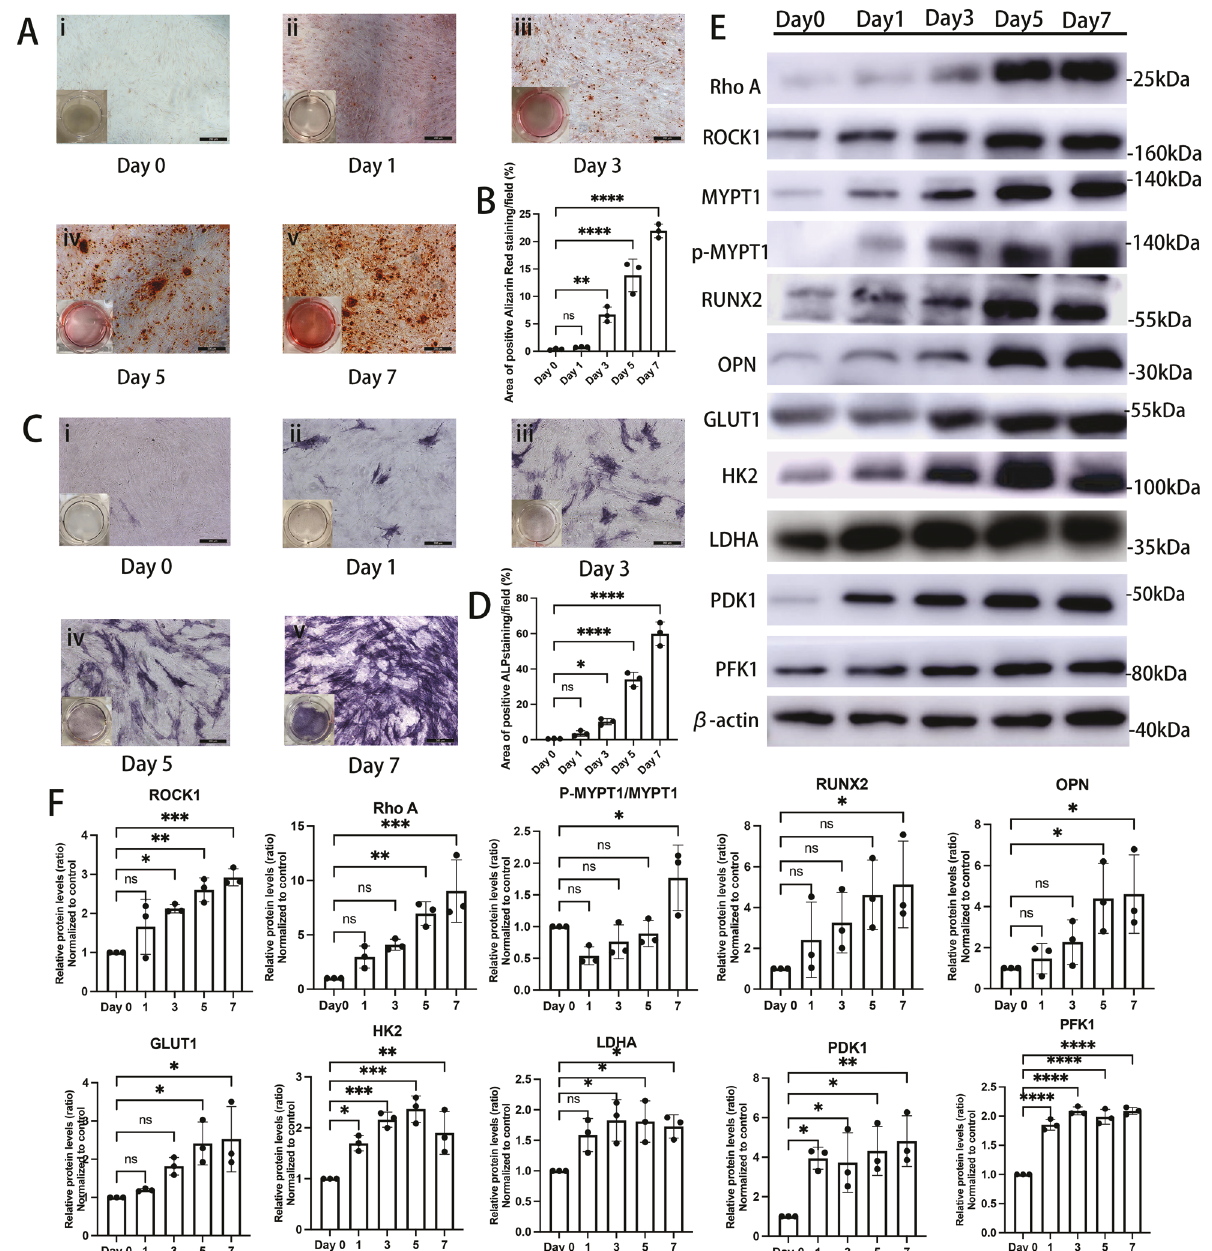
Fig. 2 IP-induced osteogenic differentiation of human VICs in vitro. A Alizarin red staining of human VICs under osteogenic stimulus for 0 (i), 1 (ii), 3 (iii), 5 (iv) and 7 (v) days. Scale bar = 200 µm. B Quanti fi cations of data presented in A (one-way ANOVA followed by Bonferroni post hoc test). C Alkaline phosphatase staining of human VICs under osteogenic stimulus for 0 (i), 1 (ii), 3 (iii), 5 (iv) and 7 (v) days. Scale bar = 200 µm. D Quanti fi cations of data presented in C (one-way ANOVA followed by Bonferroni post hoc test). E Western blotting and ( F ) quantitation for Rho A, ROCK1, MYPT1, p-MYPT1, OPN, RUNX2, GLUT1, LDHA, HK2, PFK1 and PDK1 of human VICs under osteogenic stimulus for 0, 1, 3, 5 and 7 days (one-way ANOVA followed by Bonferroni post hoc test). β -actin was used as loading control. Data are shown as mean ± SD. * P < 0.05, ** P < 0.01, *** P < 0.001, **** P < 0.0001. (Fig. 4H). Consistently, downregulation of AMPK activity dramati- cally decreased Y27632-induced upregulation of RUNX2 ubiquiti- nation in calci fi ed human VICs (Fig. 4I). Also, the half-life of RUNX2 of Y27632-treated calcifying VICs under conditions of Compound C were much higher than those only cultured with Y27632 (Fig. 4J and K). While no impact of AMPK inhibitor was observed on ROCK1 phosphorylation (Fig. 4E and F), indicating that AMPK mediates Y27632-induced reduction of VICs calci fi cation through enhancing RUNX2 ubiquitin-proteasome degradation.